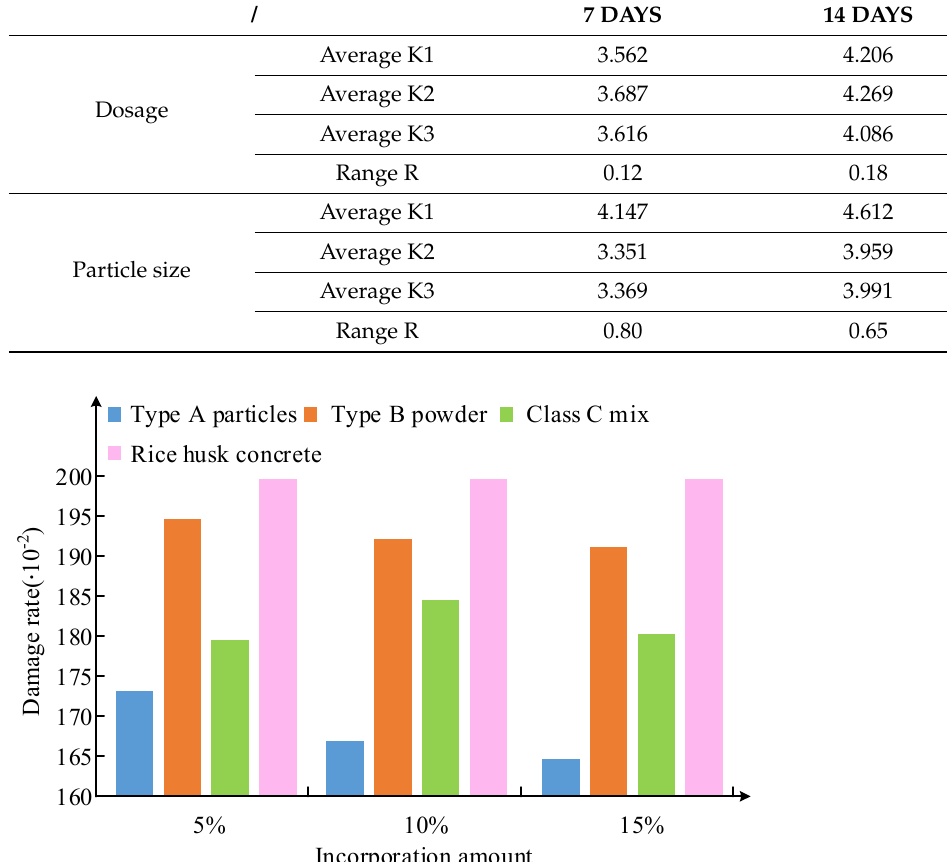
Table 5. Average and range of two variables’ influence on tensile strength.